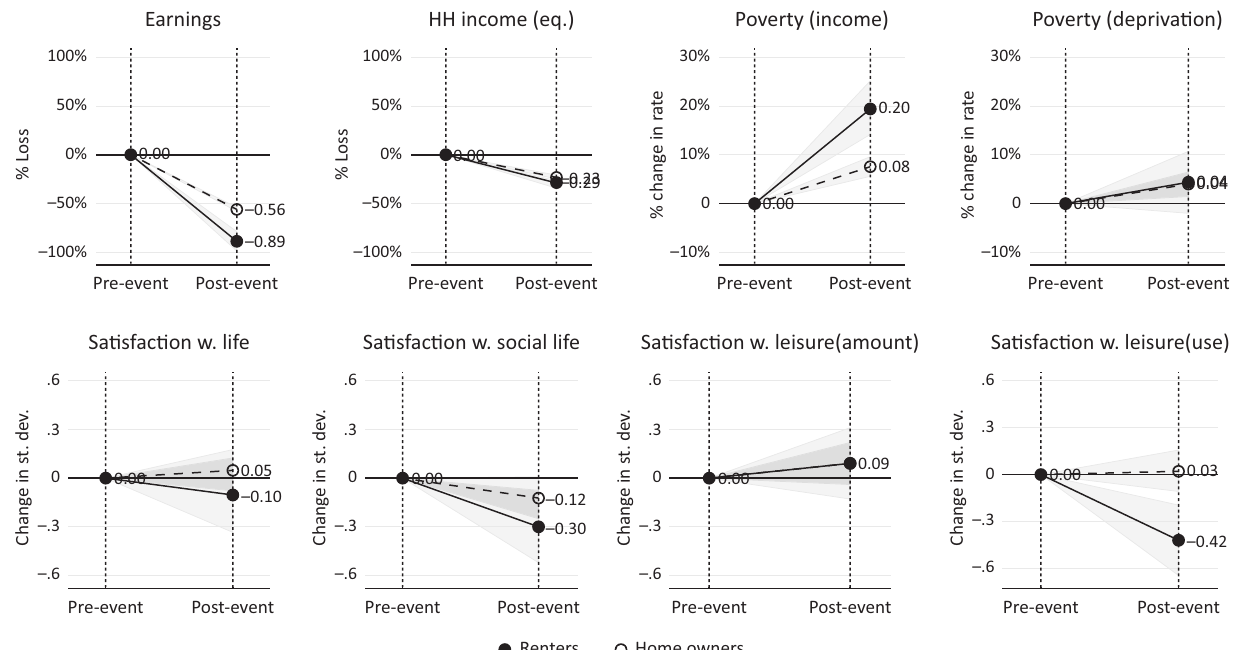
Figure 2. Outcomes in the year of job loss: Renters vs. homeowners. Notes: The graphs show changes in different outcomes in the year of job loss and how this effect varies between renters and homeowners; results for income variables show per‐ centage losses, poverty variables show increases in the risk of poverty, and satisfaction variables show changes in standard deviation; the estimates are based on a difference‐in‐differences model. The shaded areas show a 95% confidence interval of estimates; the models include other risk events such as partnership dissolution and childbirth as controls; outcomes are residualized for year, age, and gender; for definitions of outcomes see Section